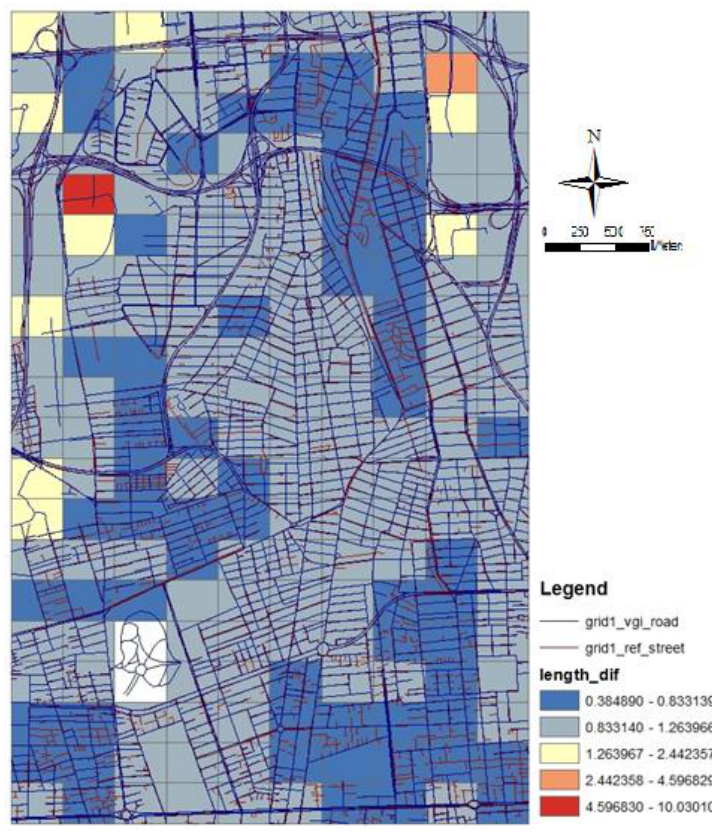
Figure 4. The calculated difference between total length of roads contained in each cell in OSM and the reference